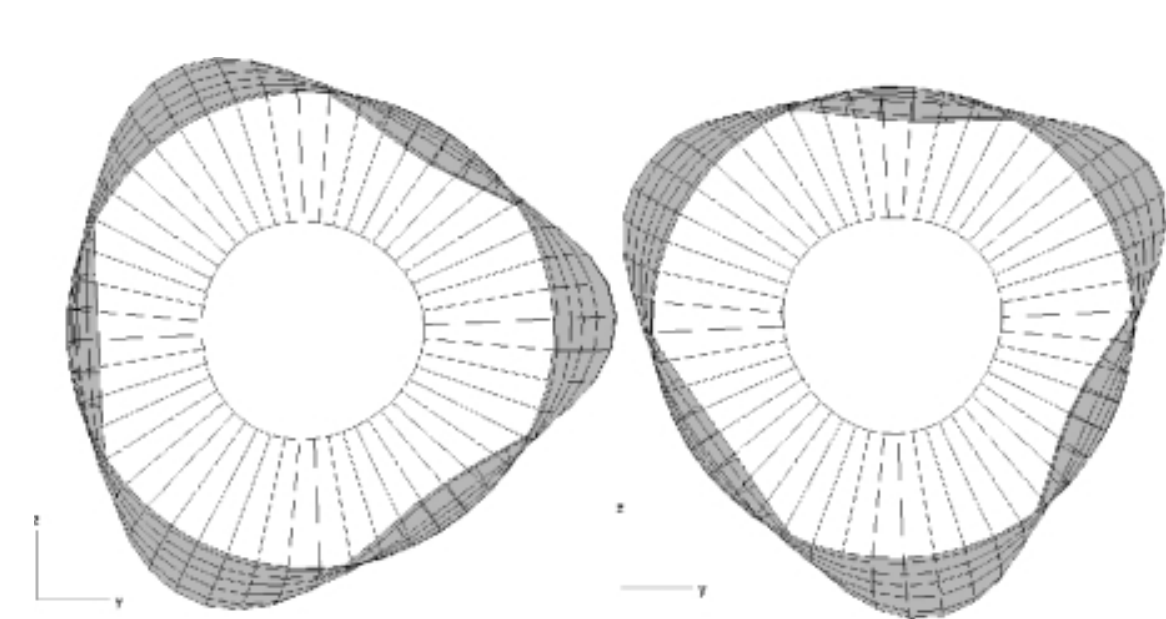
Fig. 7. Deflections of the two first residual